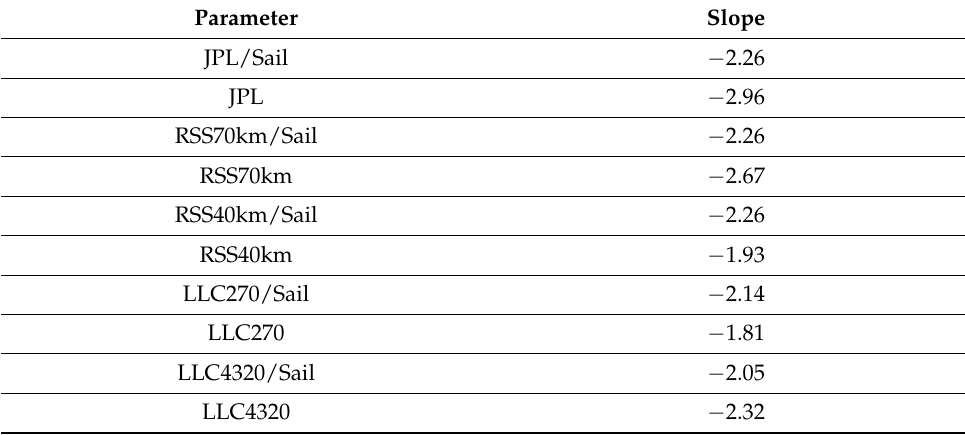
Table 2. Corresponding spectral slopes. Parameter/Sail indicates the slope of the Saildrone SSS collocated with that